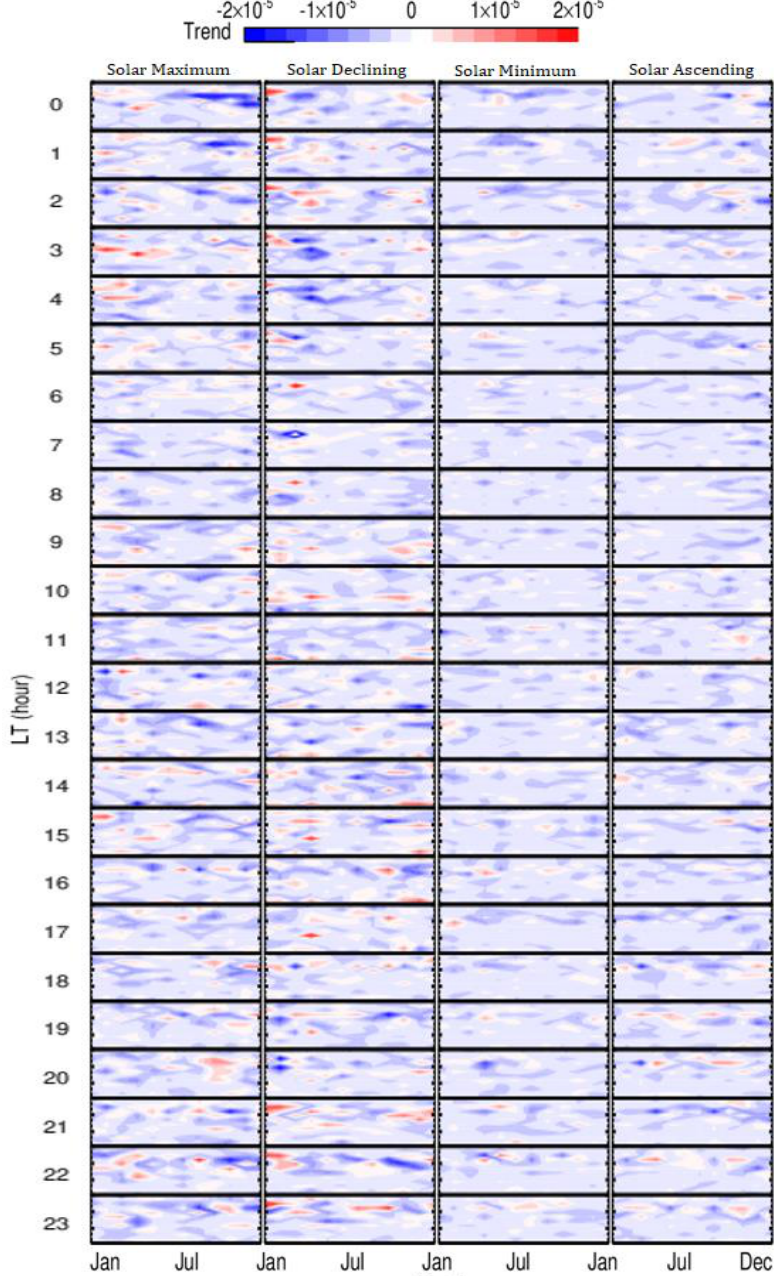
Figure 4. The effects of geomagnetic activity on global ionospheric trends depend on the local time and season. Each small graph represents the variations of the ionospheric trends caused by geomagnetic activity as a function of the month in fixed local time and solar cycle phases.